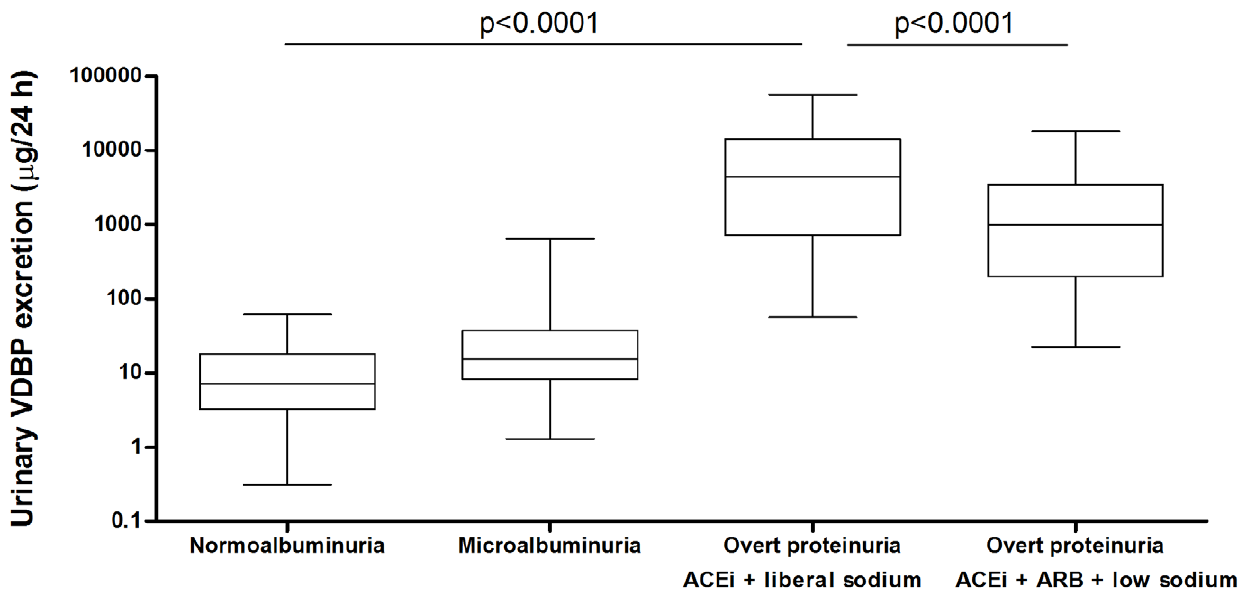
Figure 3. Urinary vitamin D binding protein (uVDBP) levels in patients with normoalbuminuria, microalbuminuria, and overt proteinuria. Box-whisker plots indicating the median, interquartile range, and range of 24-h uVDBP per patient category: general population with normoalbuminuria, general population with microalbuminuria, chronic kidney disease with overt proteinuria treated with ACE inhibitor and liberal sodium diet, and chronic kidney disease with overt proteinuria treated with ACE inhibitor + ARB + low sodium diet. UVDBP increased with albuminuria (first three groups, p , 0.001) and responded to intensification of anti-proteinuric treatment (two last groups, p , 0.001). doi:10.1371/journal.pone.0055887.g003 PLOS ONE |